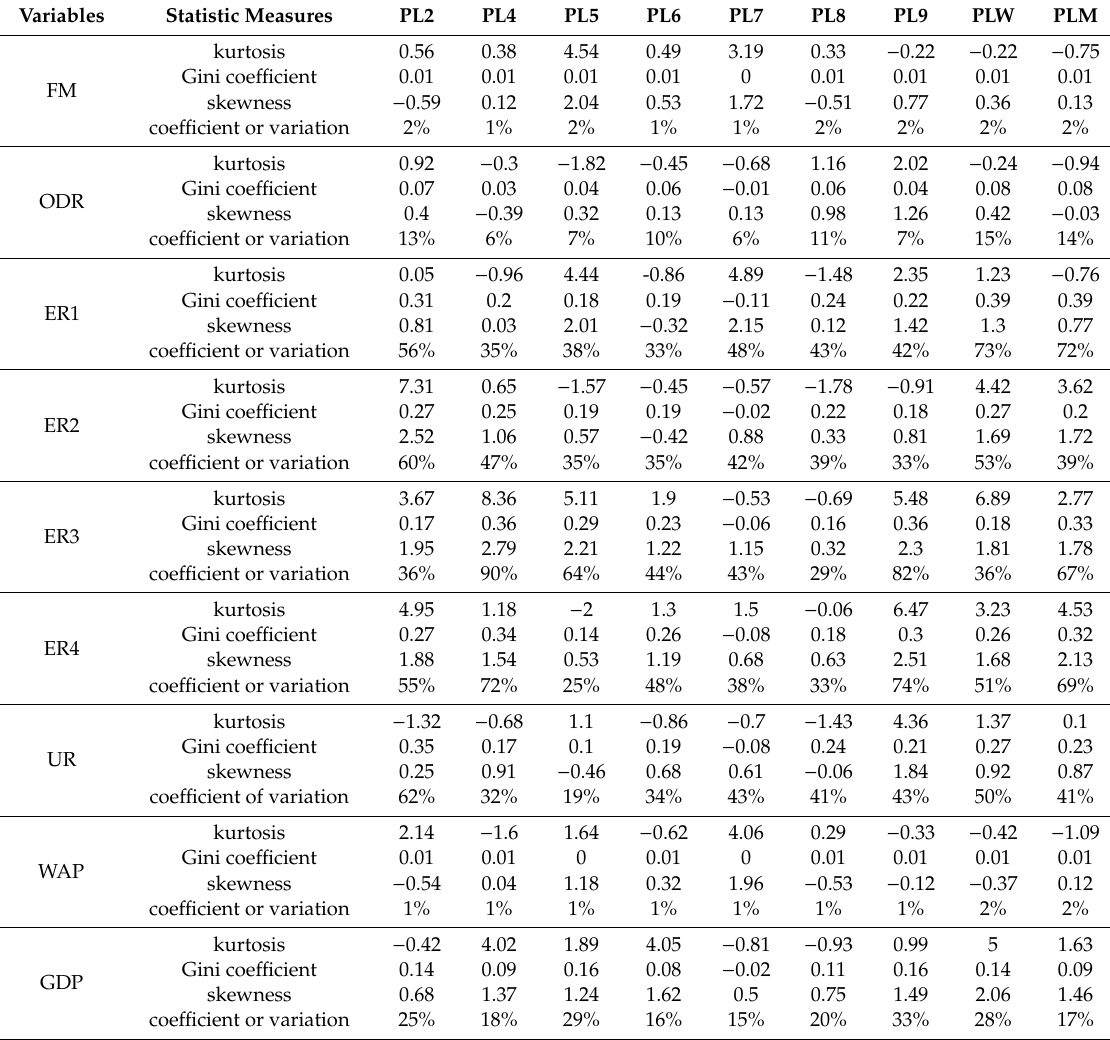
Table 4. Basic descriptive characteristics by macro-regions and types or rural